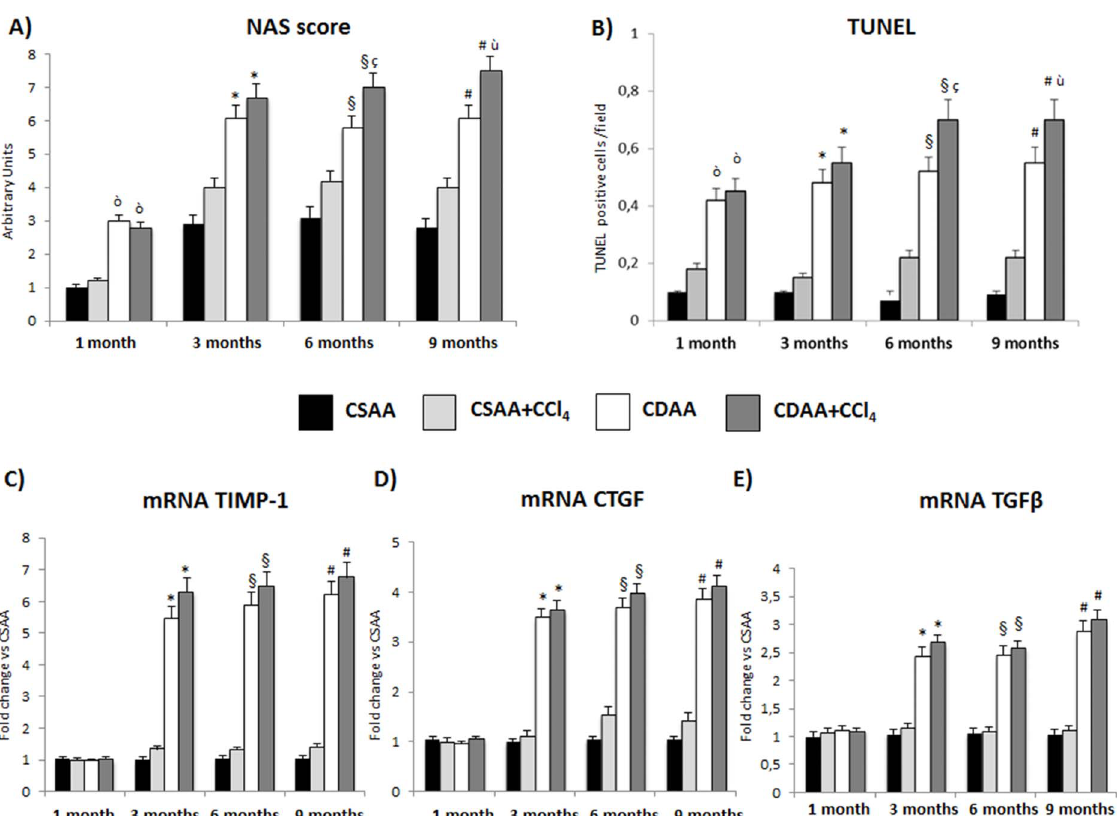
Figure 5. Treatment with CDAA or CDAA + CCl 4 induces liver injury and expression of markers of hepatic fibrogenesis in mice. A) The total degree of liver injury (hepatic steatosis and necroinflammation) was determined according to the NAS score. B) The number of apoptotic cells was measured with TUNEL and expressed as apoptotic cell/field. C–E) qRT-PCR shows a progressive increase, in a time dependent manner, of the amount of TIMP-1 (C), CTGF (D) and TGF b (E) mRNA expression in the group of CDAA, with the evidence of a promoting effect exerted by CCl 4 starting from month 3. Data represent mean 6 SD; o` p , 0.05 vs CSAA 1 month; *p , 0.05 vs CSAA 3 months; 1 p , 0.05 vs CSAA 6 months; # p , 0.05 vs CSAA 9 months; c¸ p , 0.05 vs CDAA 6 months; u` p , 0.05 vs CDAA 9 months.